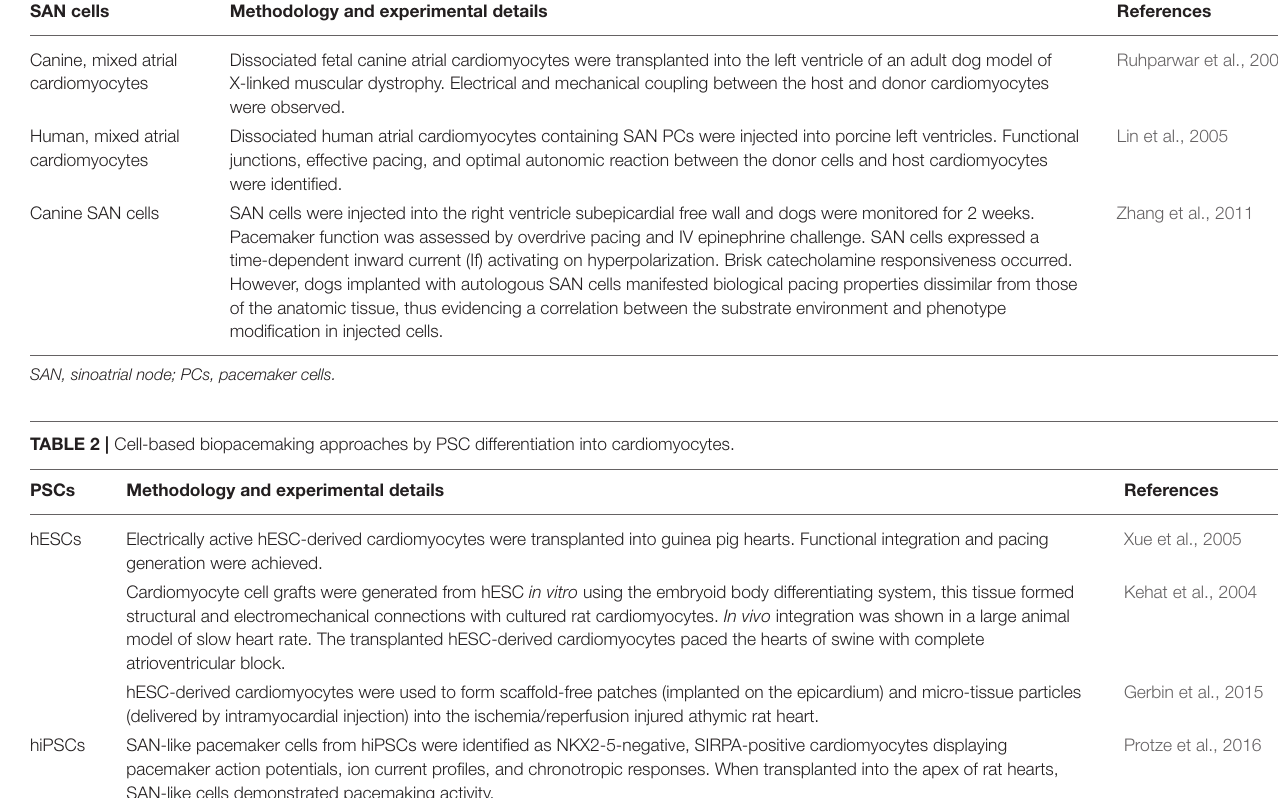
TABLE 1 | Cell-based biopacemaking approaches using SAN cells. SAN cells